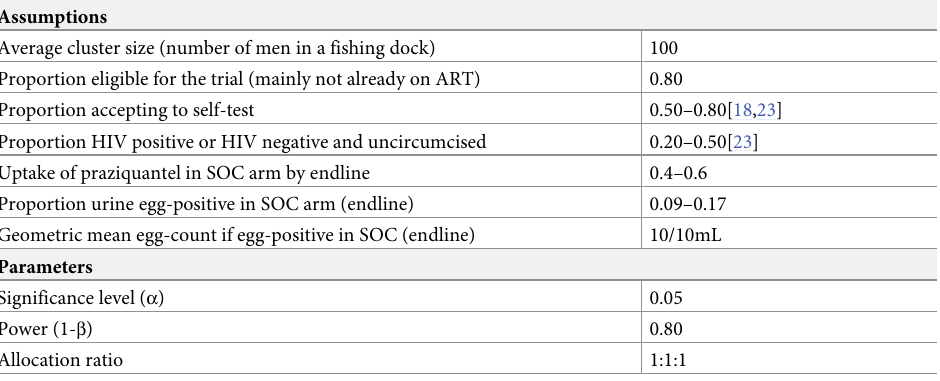
Table 1. Assumptions and parameters for sample